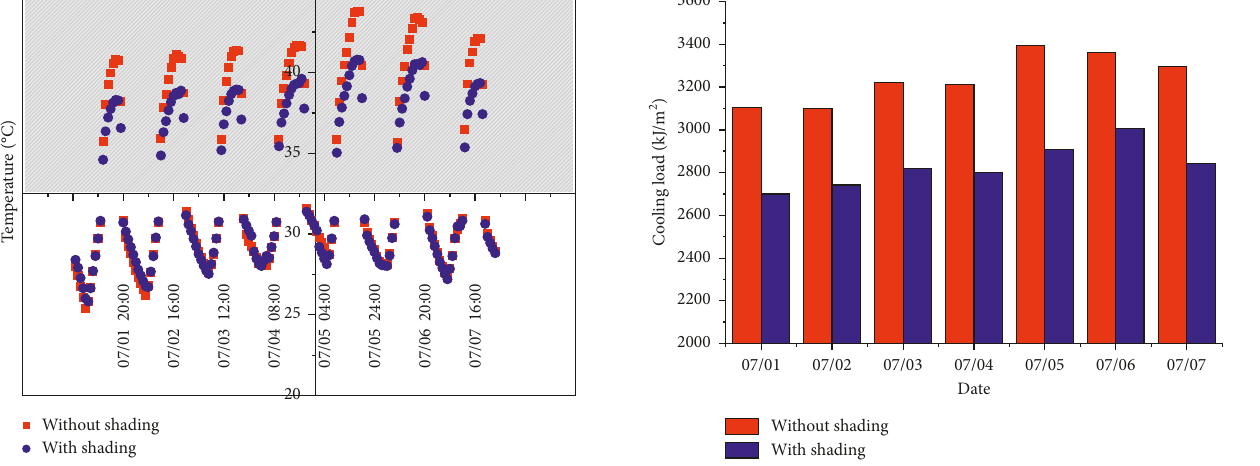
Figure 19: Cooling load comparison with and without shading/air filtration mode (source: authors’ own data).